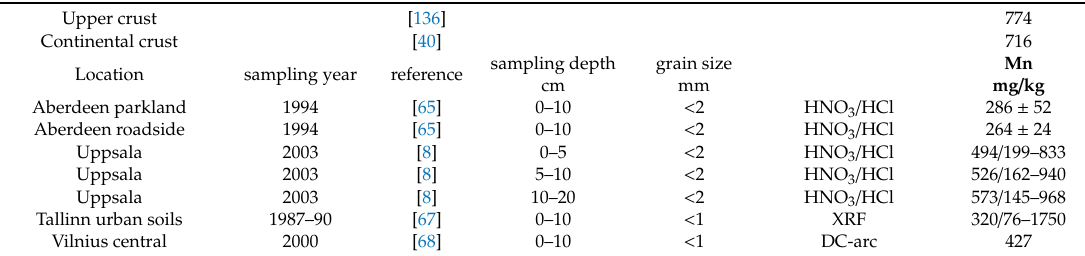
Table A13. Manganese in urban